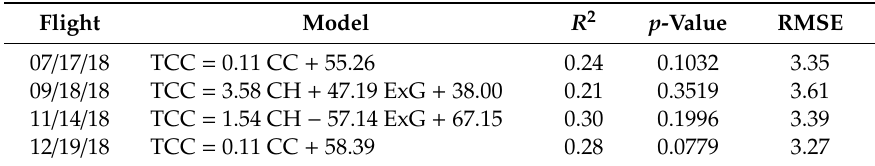
Table 5. Energy cane TCC models with the coe ffi cient of determination, p -value, and RMSE for the flight